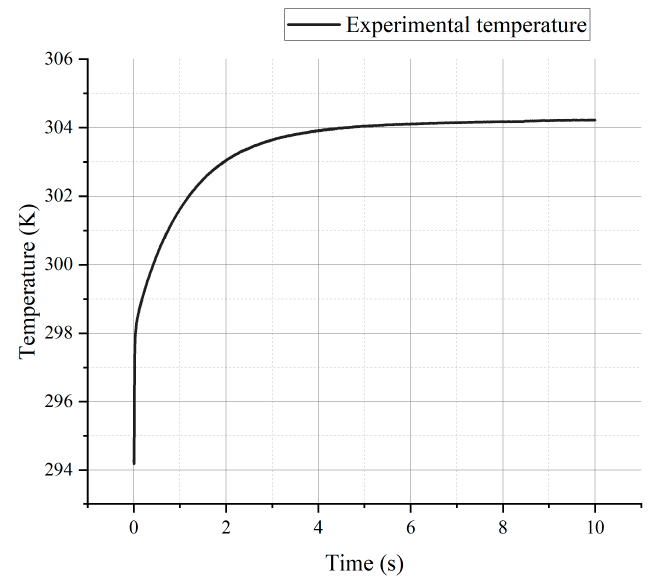
Figure 13. Experimental temperature curve changing with time.